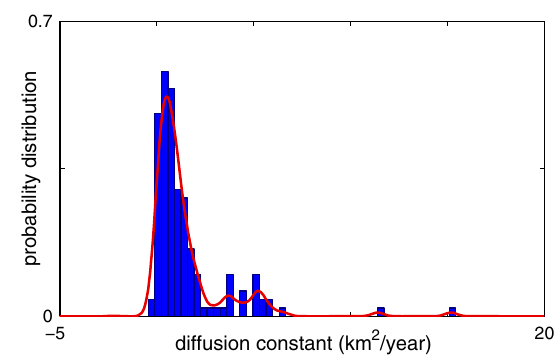
FIG. 4. Distribution of estimated diffusion constants (in km 2 = year) computed using 1985 and 2000 census data and Eq. (3). The solid curve is a kernel density estimate (from M ATLAB R2011a ’ s KSDENSITY function with default smoothing).